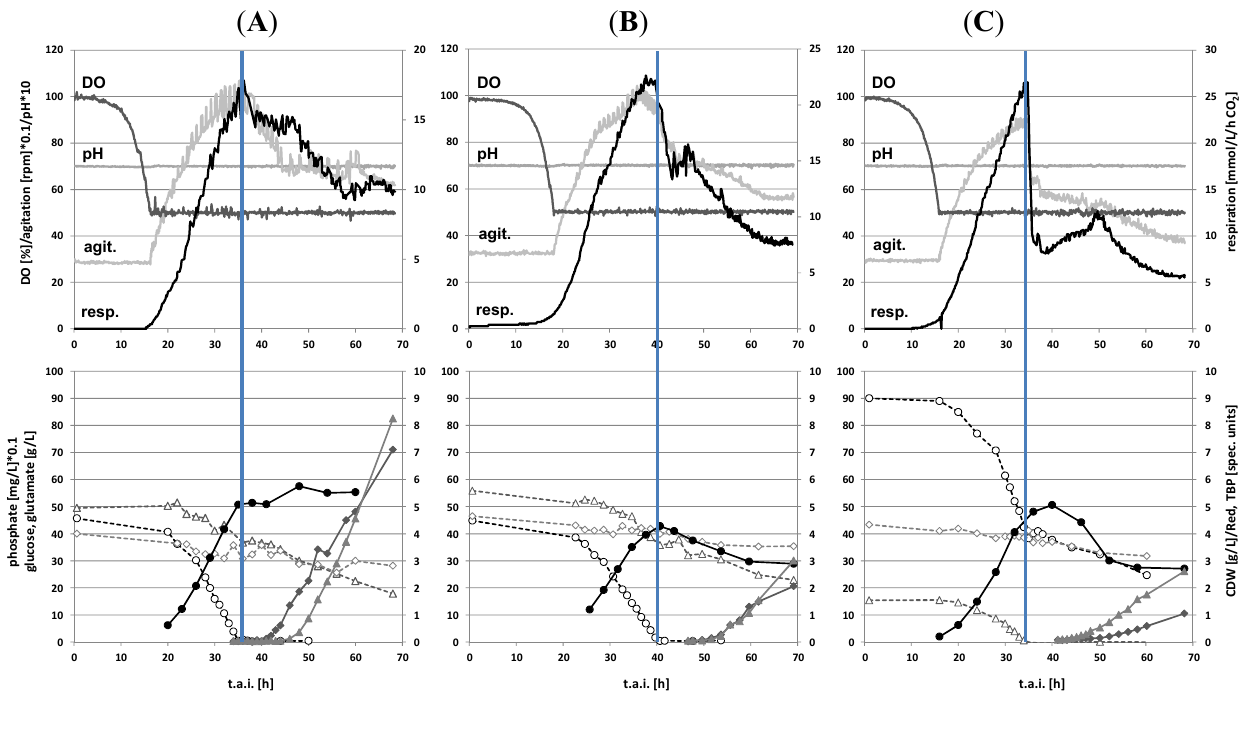
Figure 1. Batch cultivation on-line (upper panels) and off-line data (lower panels) obtained for ( A ) strain M145 on phosphate depletion medium SSBM-P; ( B ) strain INB201 (  phoP ) on phosphate depletion medium SSBM-P; and ( C ) strain M145 on glutamate depletion medium SSBM-E. The time when the respective limiting nutrient is depleted from the medium is given as a vertical blue line. In the lower panels, dry weight concentrations are depicted as solid circles, glutamate concentrations as open triangles, glucose concentrations as open diamonds, phosphate concentrations as open circles, TBP (total blue pigments, i.e. , actinorhodins) as solid triangles, Red (undecylprodigiosin) as solid diamonds. The upper panels depict results from continuous monitoring of dissolved concentration in the off-gas oxygen concentration (DO), pH, agitation (agit.) and CO 2 (resp.). t.a.i. time after inoculation. ( A ) ( B ) ( C ) 0510152025 020406080100120 051015202530 020406080100120 05101520 020406080100120 05101520 020406080100120 DO DODO pH pHpH agit. agit.